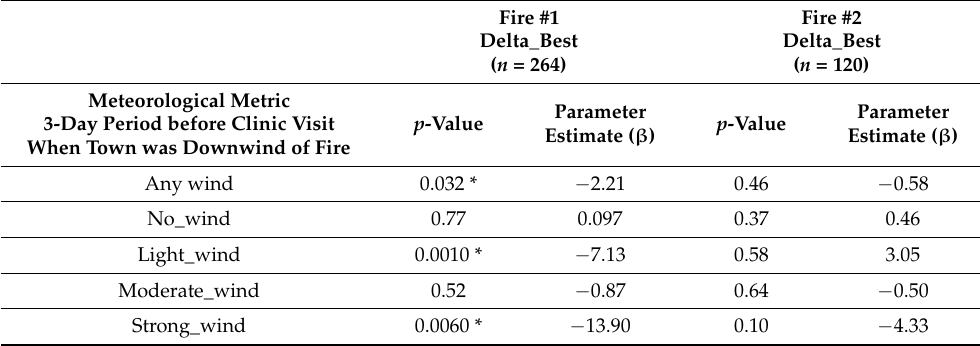
Table 4. Adjusted multivariate linear regression with an outcome variable of delta_best during the post-fire period (i.e., clinic measured peak flow in liters per minute minus the patient’s personal best peak flow), with predictors including meteorological parameters of the percentage of time the wind was from the northwesterly direction during fire blowing from fire towards the town (light wind was a Beaufort scale of 3 = 1.5–5.5 m/s; Beaufort 4–5 = 5.5–10.7 m/s = moderate wind; Beaufort > 6 = >10.7 m/s = strong wind) (note: northwesterly wind is the direction the wind was coming from, meaning the wind was blowing from the northwest to the southeast. In other words, from the fire to the community